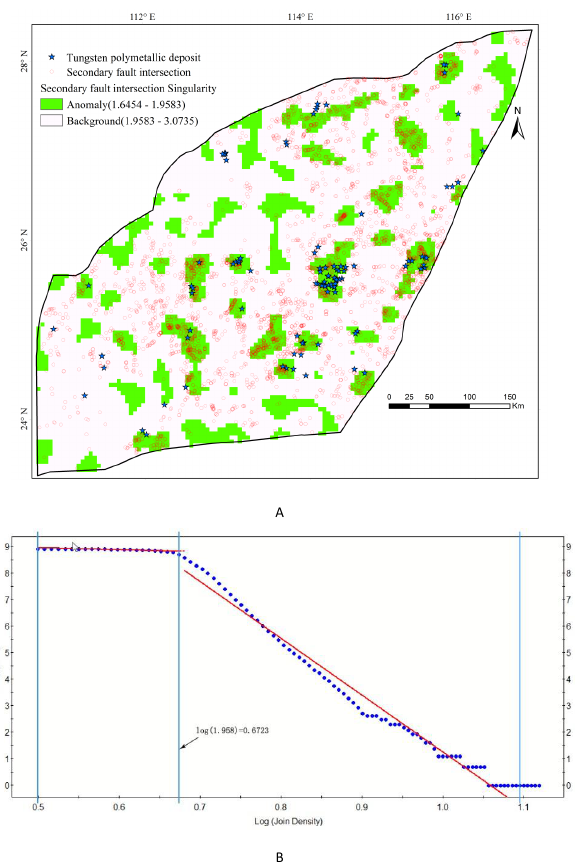
Fig.6. (A) Concentration–area map for the secondary fault intersections, and (B) Log–log plots for 443 Fig. 6. (A) Concentration–area map for the secondary fault intersec- tions, and (B) Log-log plots for the secondary fault intersections.